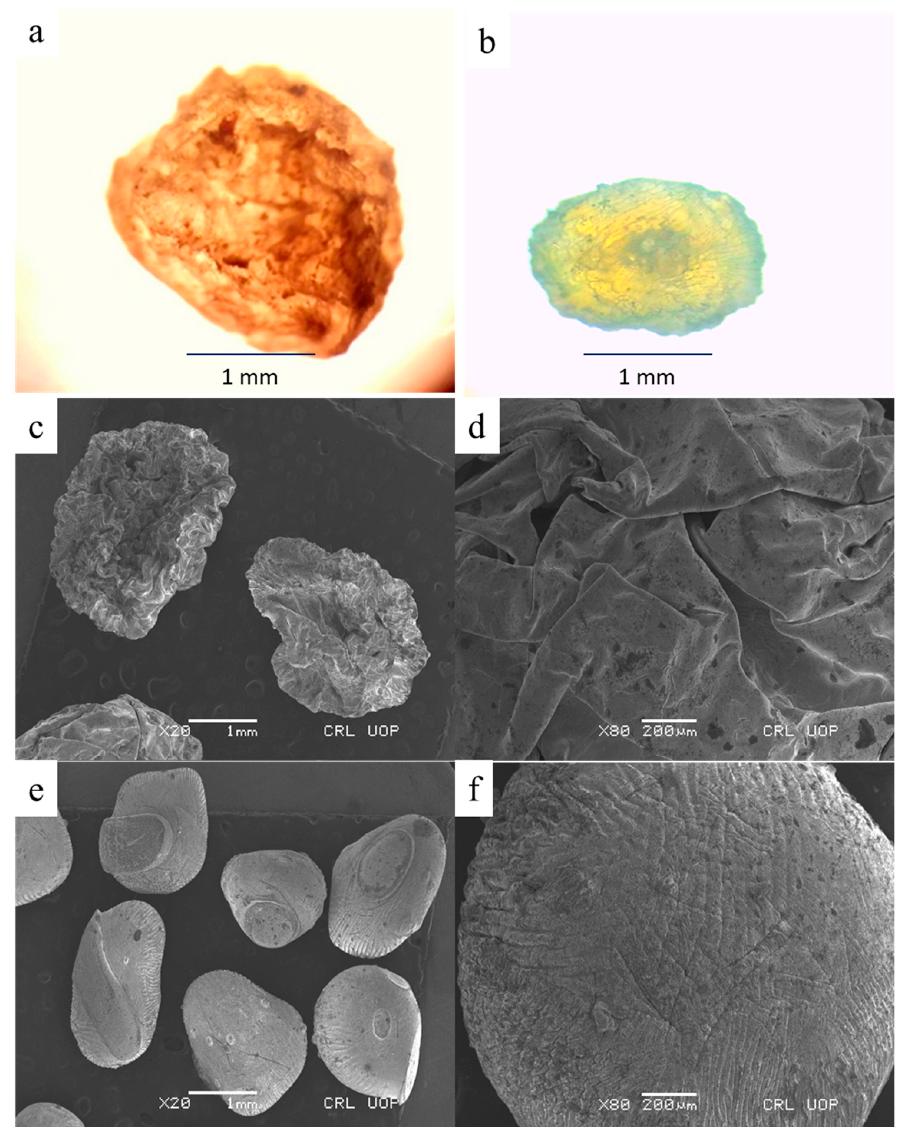
Figure 5. Surface morphology of ( a ) FA-CS-5FU-NP-Bf, ( b ) FA-CS-5FU-NP-Bo, ( c , d ) SEM FA-CS-5FU- NP-Bf, and ( e , f ) Table 1. Mean diameter and shape of FA-CS-5FU-NP-Bf and FA-CS-5FU-NP-Bo. Beads Size (mm)